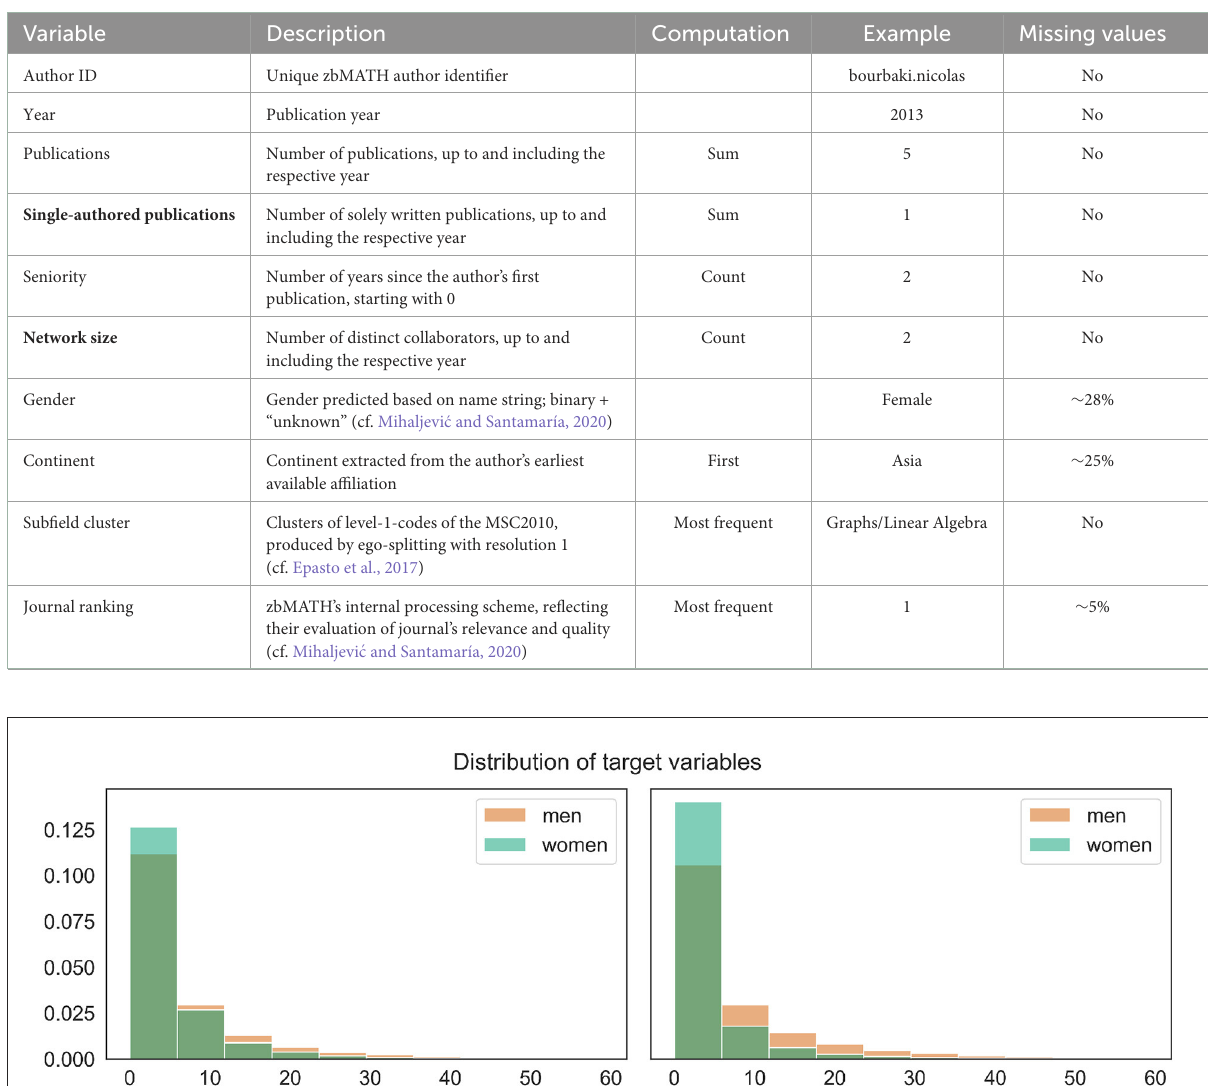
TABLE 2 Description of all variables in the final dataset, with target variables highlighted in bold. Variable